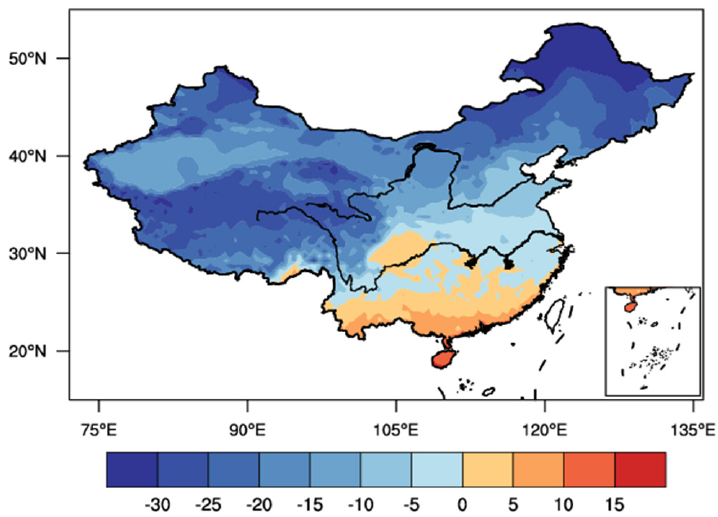
Figure 1. Average daily thresholds for extreme low temperatures (units: °C) in winter from 1979 to 2019 in China.